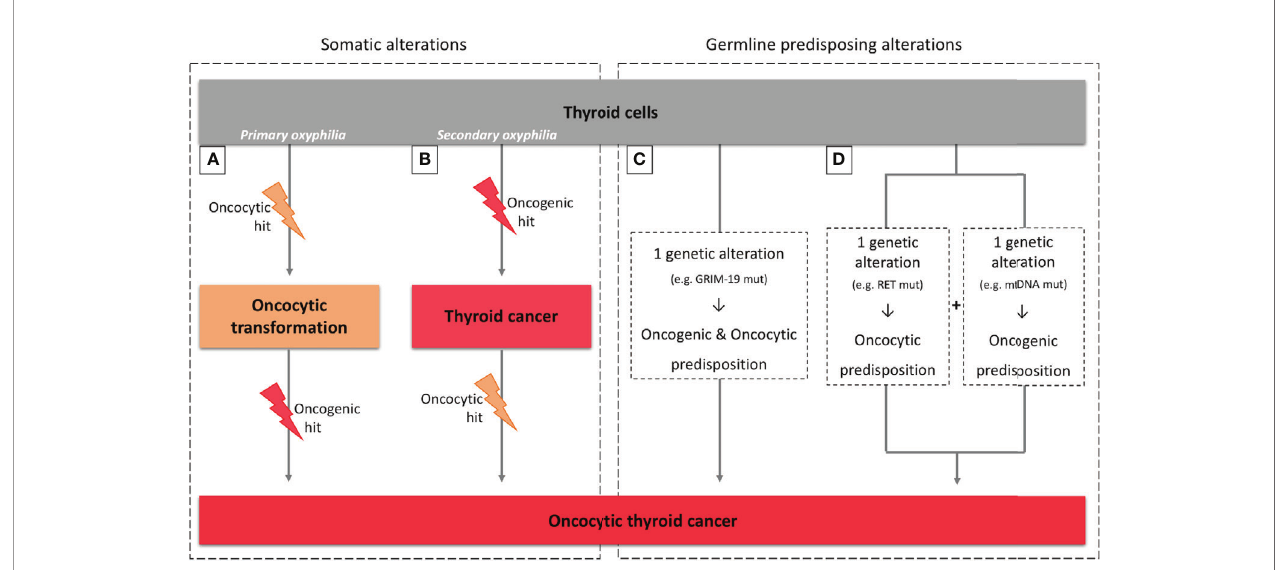
FIGURE 1 | Parallelism between sporadic and hereditary tumors for primary/secondary oxyphilia. (A, B) scheme representing the primary and secondary oxyphilia concepts and the respective time of occurrence of the somatic oncogenic and oncocytic events; (C, D) scheme representing the primary and secondary oxyphilia in relation to the genetic predisposing alterations to oncocytic thyroid